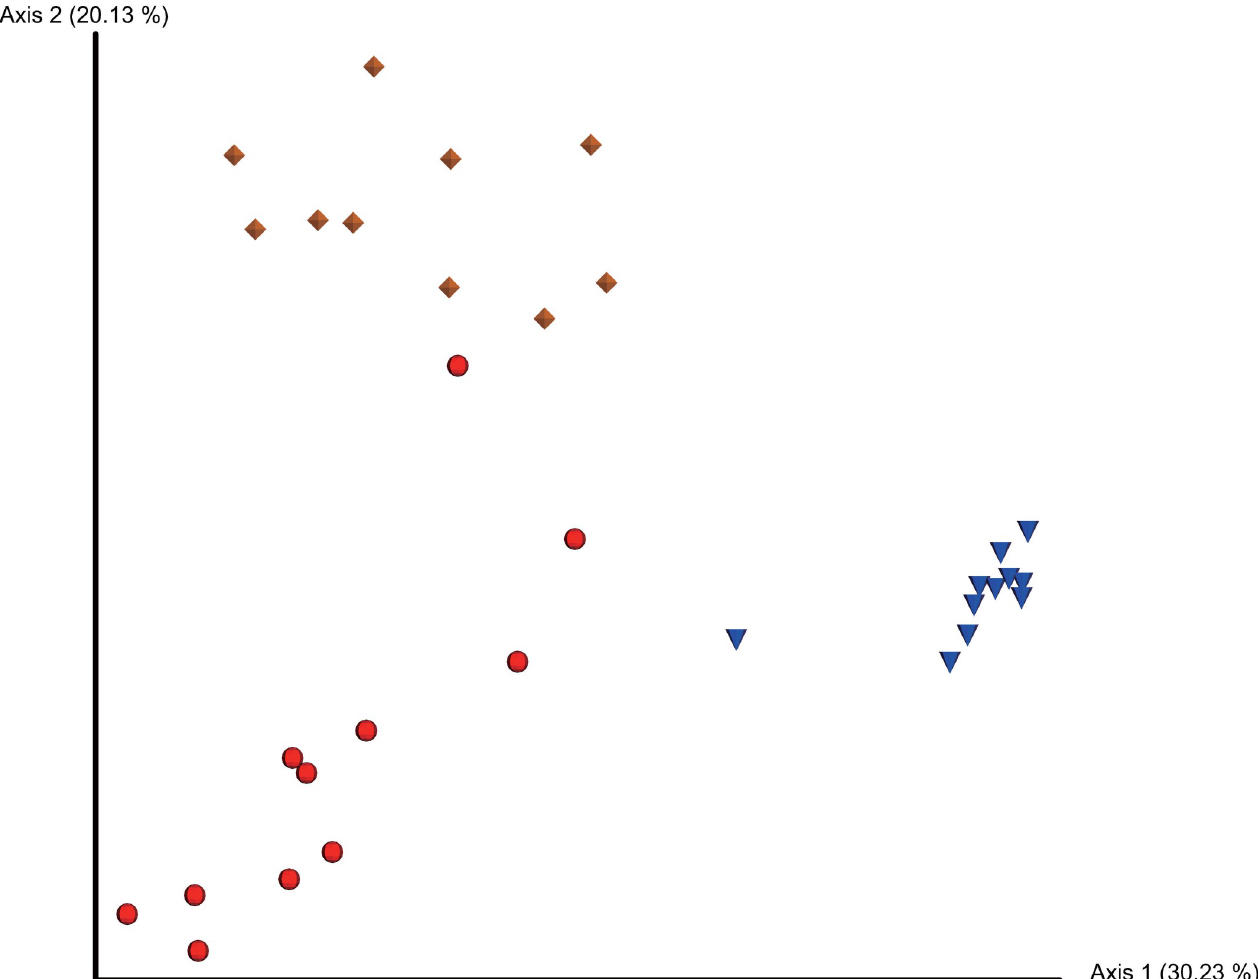
Fig 2. PCoA plot based on unweighted unifrac distance matrix. PCoA plots demonstrating unweighted unifrac distance among microbiota in the cloaca, colon, and magnum of laying hens. Red spheres represent the cloaca, blue spheres represent the colon, and yellow diamonds represent the magnum.